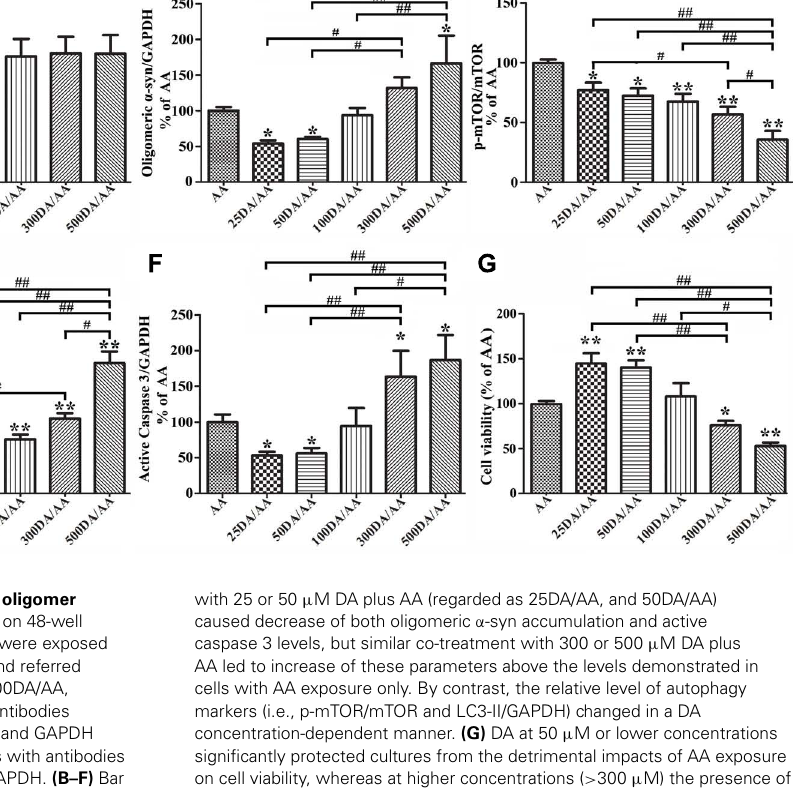
with 25 or 50 μ M DA plus AA (regarded as 25DA/AA, and 50DA/AA) caused decrease of both oligomeric α -syn accumulation and active caspase 3 levels, but similar co-treatment with 300 or 500 μ M DA plus AA led to increase of these parameters above the levels demonstrated in cells with AA exposure only. By contrast, the relative level of autophagy markers (i.e., p-mTOR/mTOR and LC3-II/GAPDH) changed in a DA concentration-dependent manner. (G) DA at 50 μ M or lower concentrations significantly protected cultures from the detrimental impacts of AA exposure on cell viability, whereas at higher concentrations ( > 300 μ M) the presence of DA caused a significant reduction of cell viability (* p < 0.05, ** p < 0.01 comparing to AA; # p < 0.05, ## p < 0.01, comparing subsets linked by